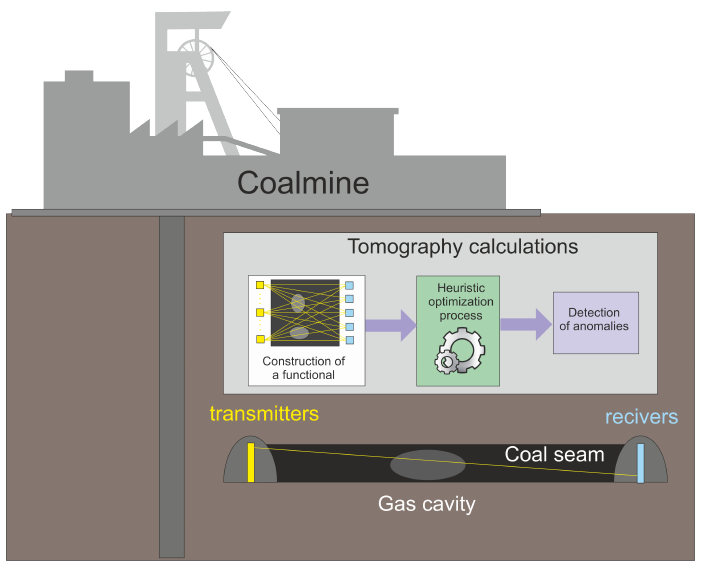
Figure 2. Illustrative drawing visualizing the operation of the anomaly detection system in coal